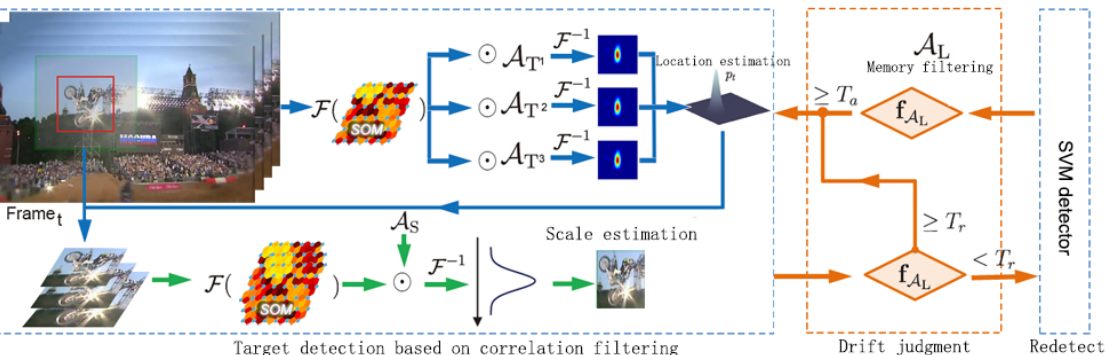
Figure 3. The proposed algorithm